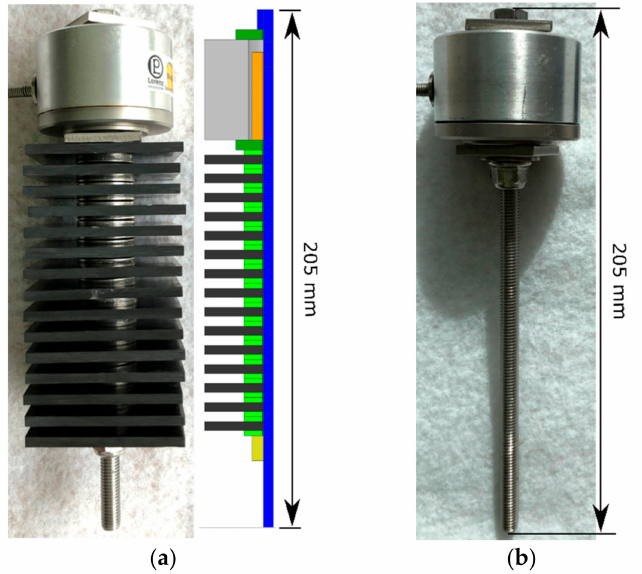
Figure 6. Screw assemblies for measurement of pretension loss; screw assembly ( a ) with 15 C-SMC specimens; screw assembly ( b ) with only steel